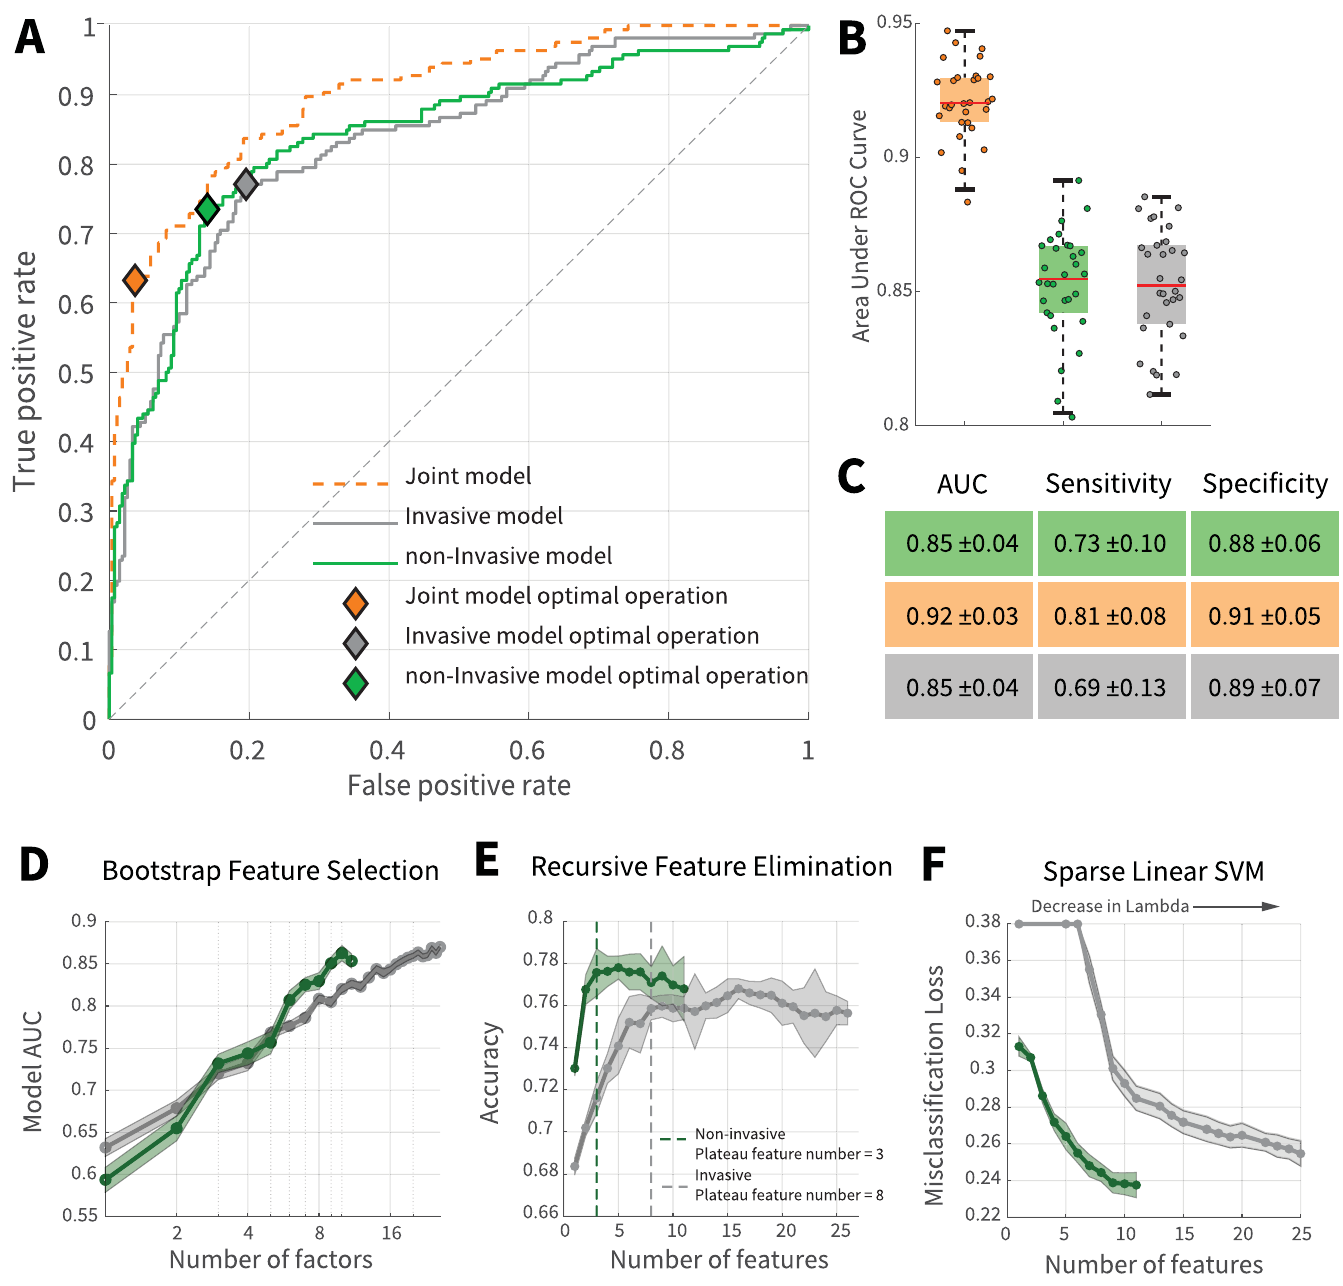
Fig 3. Comparison of mortality prediction of invasive and non-invasive models. ( A ) ROC curve of joint, invasive, and non-invasive models. ( B ) Investigation of models’ performance and robustness towards sample size. For each data point, a model was trained and evaluated using 90% of data which was randomly bootstrapped from the main dataset while maintaining the original discharge to expired ratio. The models were robust to the sample size and no significant difference was observed between the performance of invasive and non-invasive models. ( C ) Performance table of invasive, non-invasive, and joint models. Performances are reported as mean along with standard deviations. ( D ) Comparing the dynamics of laboratory and non-invasive features for randomly selected combinations of features. ( E ) Recursive feature elimination. Compared with invasive features, prominent non-invasive features had significant prediction information contents. In general, the first three features with prominent contributions to the improvement of the non-invasive model’s performance were SPO 2 , age, and presence of cardiovascular disorders; the first three invasive features were BUN, LDH, and PTT. ( F ) Sparsity analysis. Sparse linear SVM was utilized to investigate optimal feature combinations for fixed predictor numbers. For a specific sparsity level (features number), the non-invasive model performs better than the invasive model. Green and gray represent non-invasive and invasive modes, respectively.